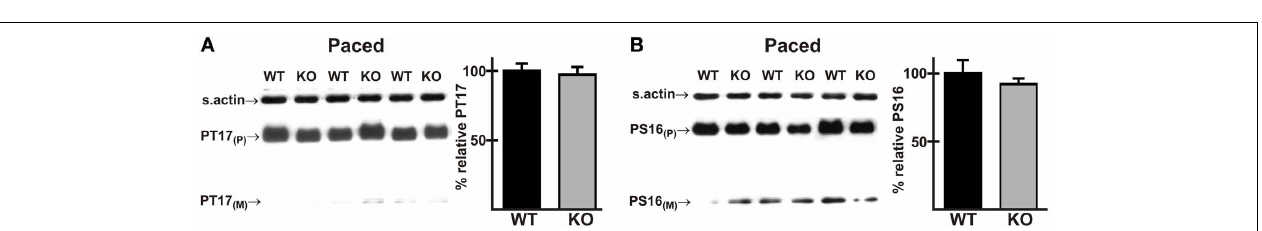
representative tracings; (B) Ca 2 + -transient amplitudes; and (C) time to 50% recovery of Ca 2 + -transients in response to electrical field-stimulation at 0.5Hz. Values are means ± SE, n = 3 mice per genotype (at least 36 cells/genotype).